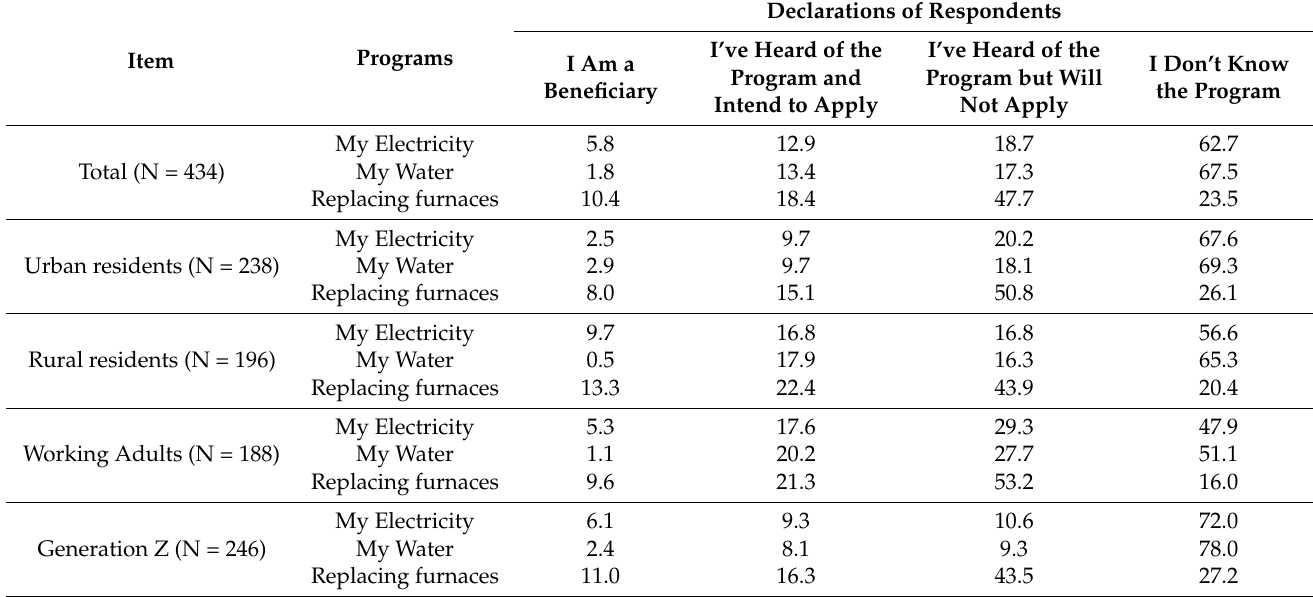
Table 2. The respondents’ declarations regarding the knowledge and use of the government pro-environmental programs by place of residence and age